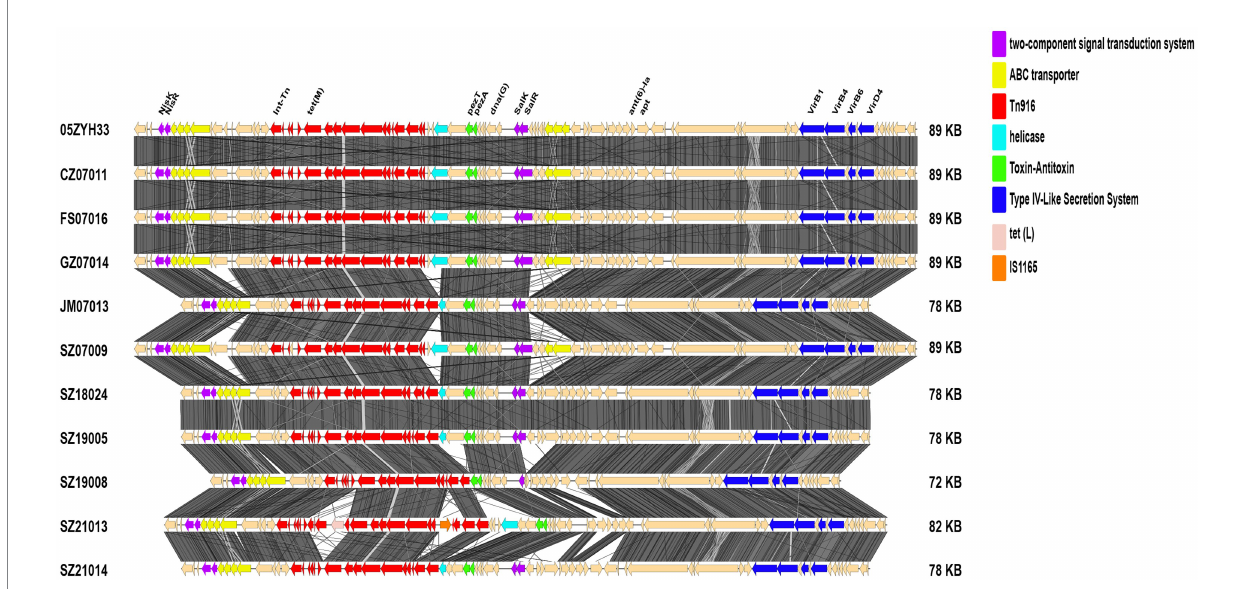
FIGURE 5 Structural diagram of the 89 KB PAI and its variants found in the Shenzhen